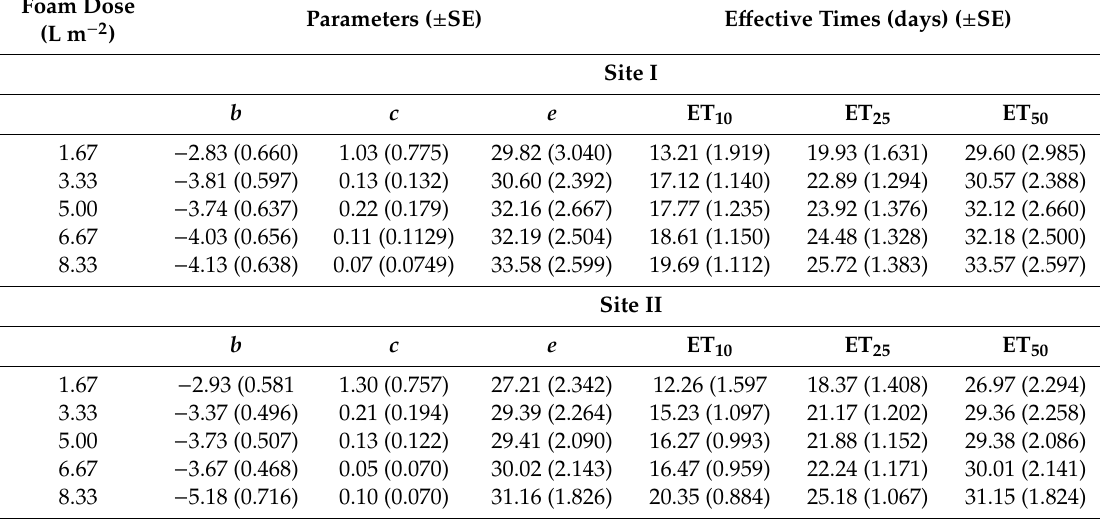
Figure 5. Log-logistic regression curves with average points of weed cover percentage as a ff ected by the foam dose (0, 1.67, 3.33, 5.00, 6.67, and 8.33 L m − 2 , respectively) and the evaluation date in the two-site field experiment infested with Festuca arundinacea (Schreb.). DAT: days after the treatment. The parameters of the non-linear regression curves (Equation (1)) are reported in Table 5. Regrowth was from weeds death (i.e., three days after hot foam application) to one month after death. Table 5. Parameters and standard errors (SE) of the log-logistic regression model (Equation (1)) and e ff ective times (days) estimated for reaching 10%, 25%, and 50% weed cover regrowth (ET 10 , ET 25 , and ET 50 , respectively) as a ff ected by the di ff erent foam doses at di ff erent dates of data collection in the two-site field experiment infested with Festuca arundinacea (Schreb.). The non-linear regression curves are plotted in Figure 5. Regrowth was from weeds death (i.e., three days after hot foam application) to one month after death.